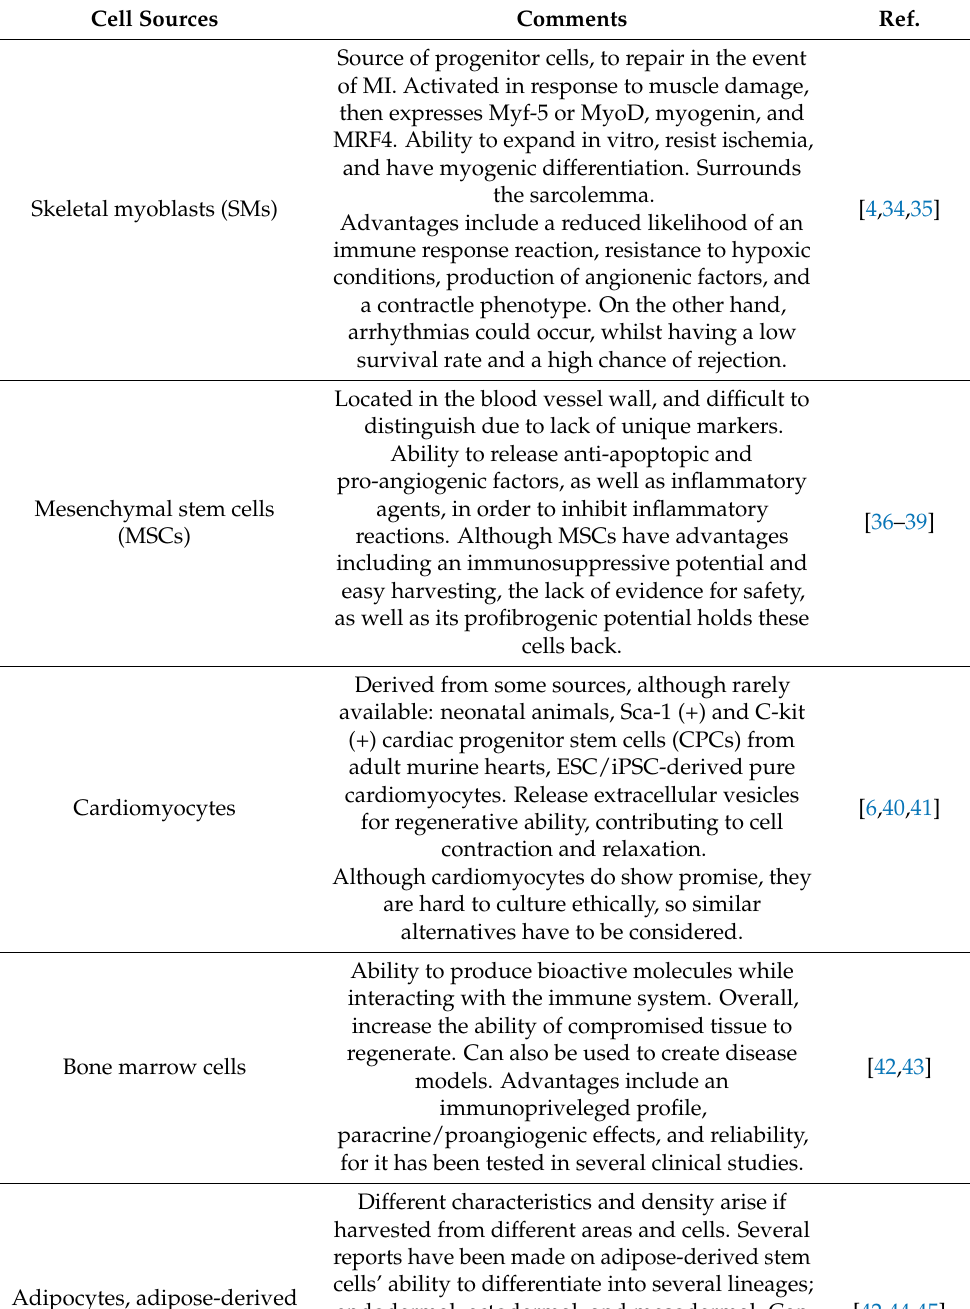
Table 1. Exploring several cell sources for the creation of hCMP, such as SMs, MSCs, Bone marrow cells, adipocytes, and